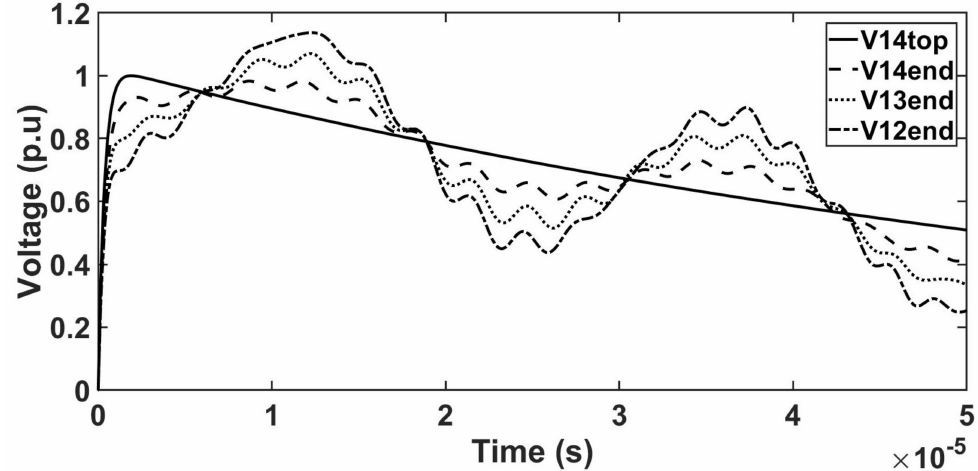
Figure 18. Surge voltage waveforms for shield placement between layer 14 and layer 13 and between layer 13 and layer 12 of HV winding under